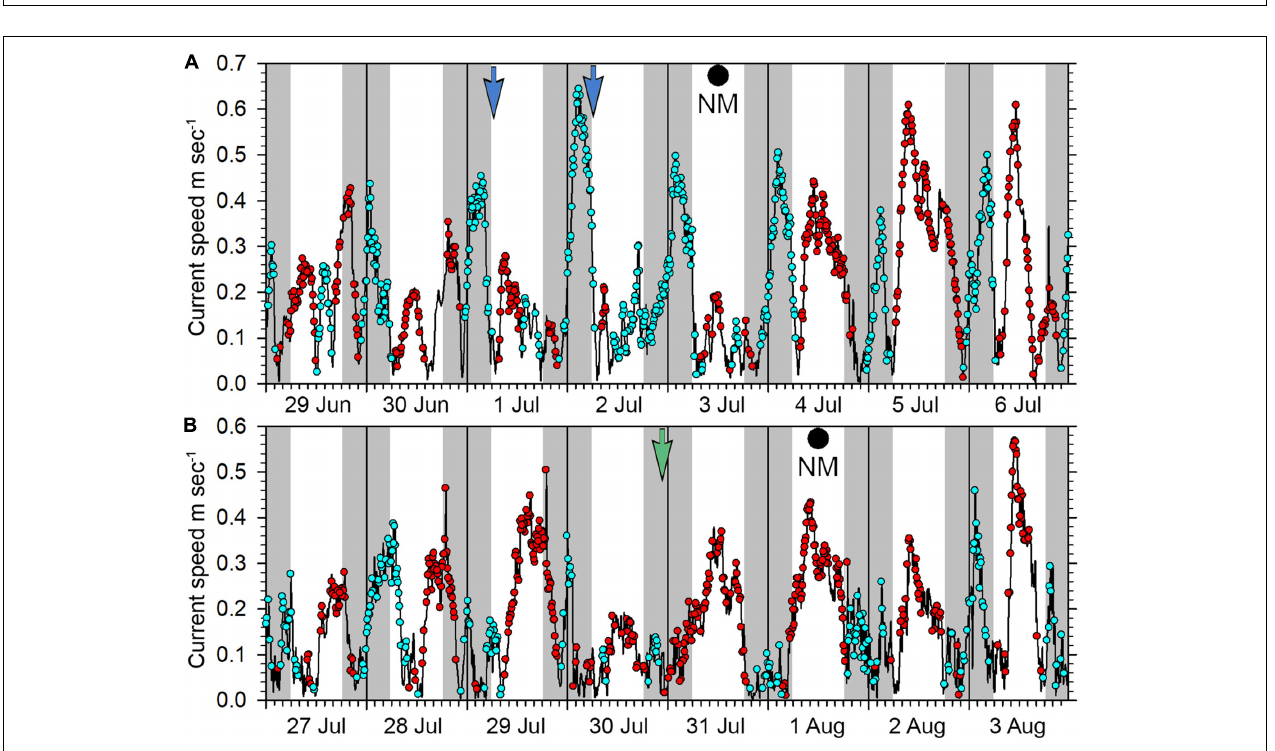
FIGURE 14 | Current patterns at the Ebiil aggregation site from (A) 29 June to 06 July 2019, (B) 27 July to 03 August 2019. Blue dots represent outgoing current direction, red dots incoming. Night periods are indicated by gray shading, day by white background. The blue arrows on 01 and 02 July indicate time of heightened activity of E. fuscoguttatus while the green arrow on July 30 indicates likely spawning of E. polyphekadion on this date. New moons were July 03 and August